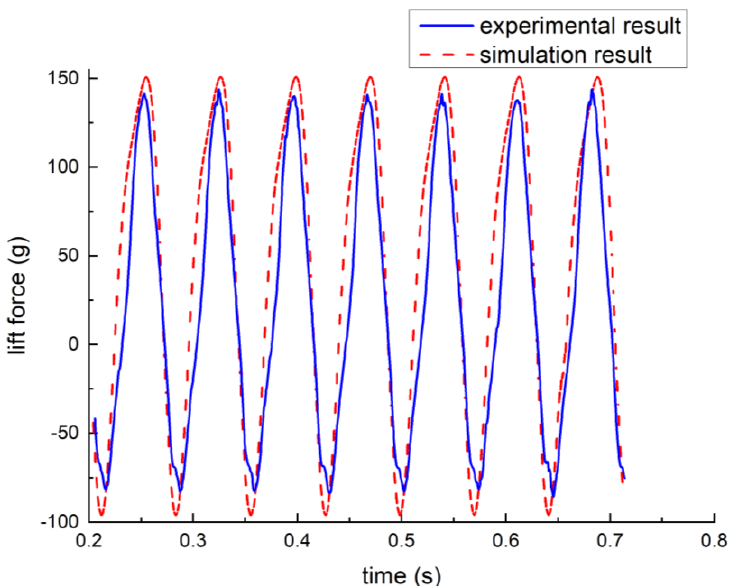
Figure 11. Comparison of real-time lift results between experiment and CFD.